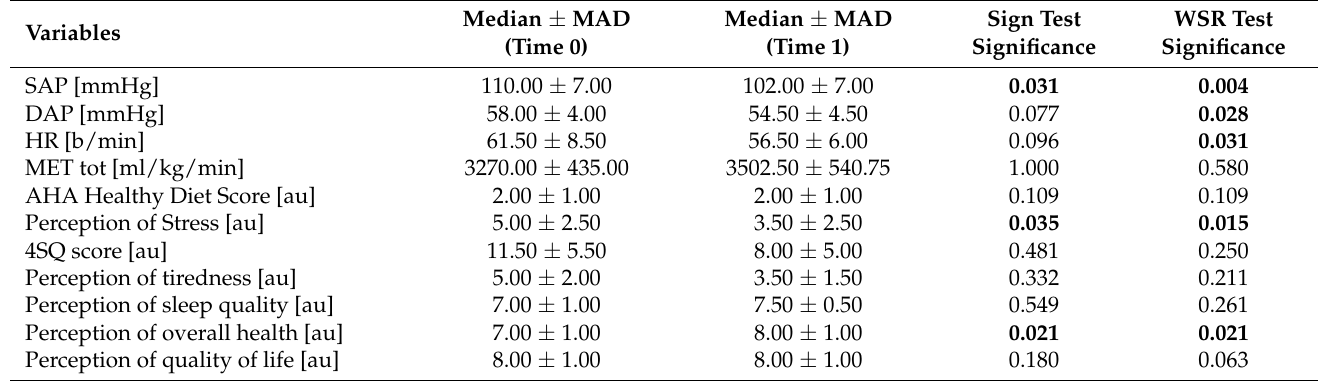
Table 1. Subjects’ anthropometric/hemodynamics parameters and lifestyle assessment data at T0 and T1: summary statistics (median ± MAD) and two-tailed non-parametric statistical